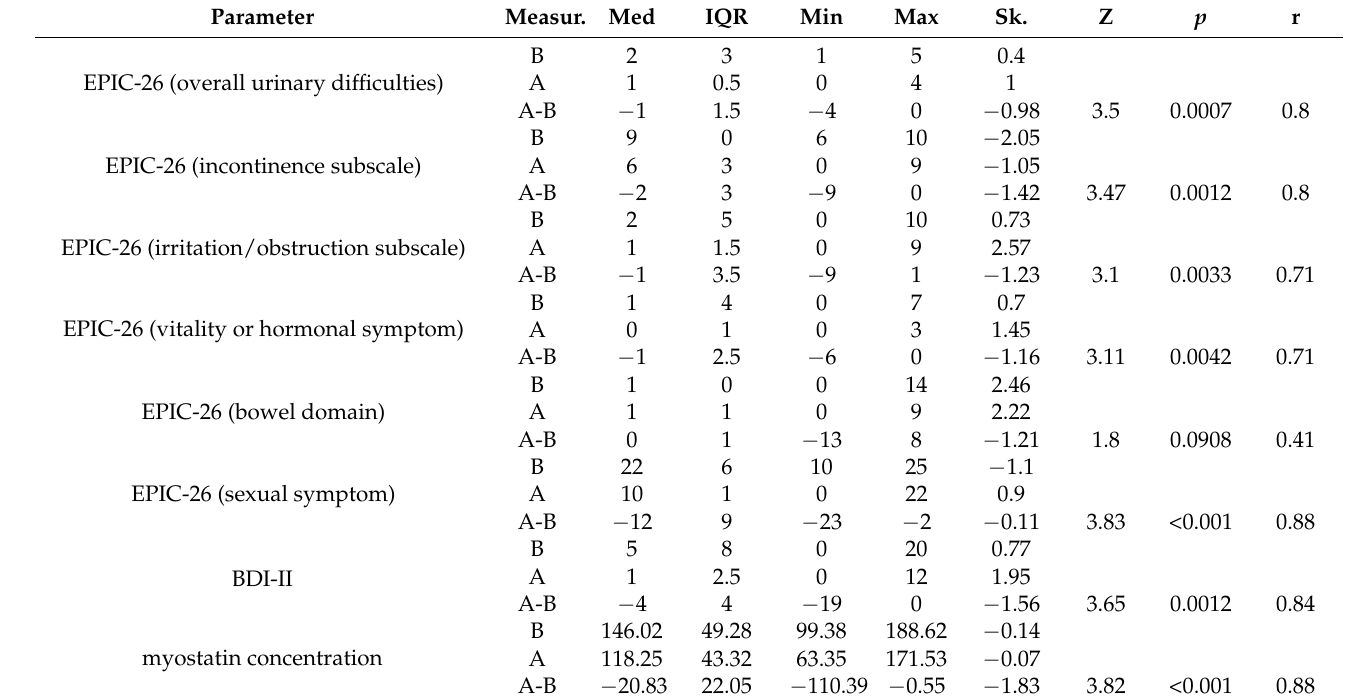
We found that the groups did not differ significantly before the treatment in seven out of eight measured parameters. The experimental group had statistically significant and moderately higher average level of the myostatin concentration than the control group. Table 3 shows a comparison of variables measured in the EG during the initial and final assessments. Table 3. Comparative analysis of variables measured for the EG at the initial and final assessments. Parameter Measur.